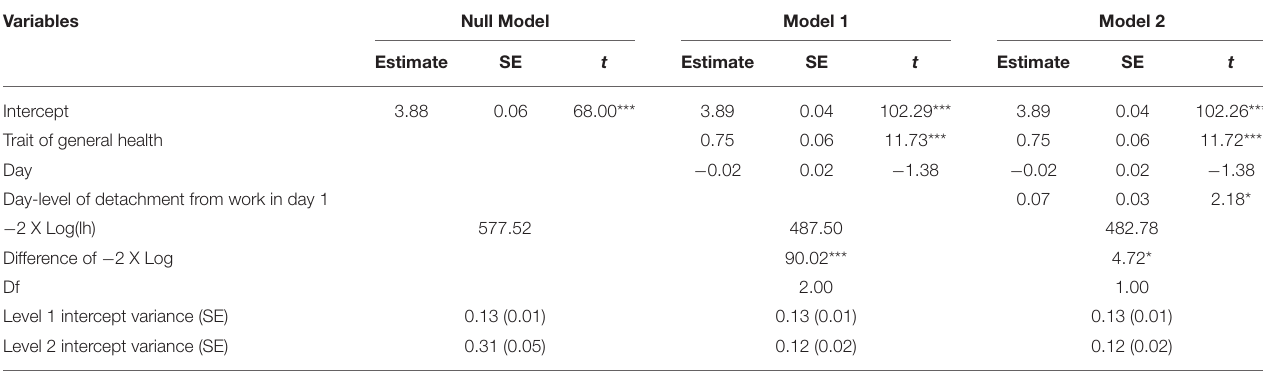
TABLE 5 | Multilevel estimates for models predicting day-level of next-day general health ( N = 520 observations, N = 104 participants).